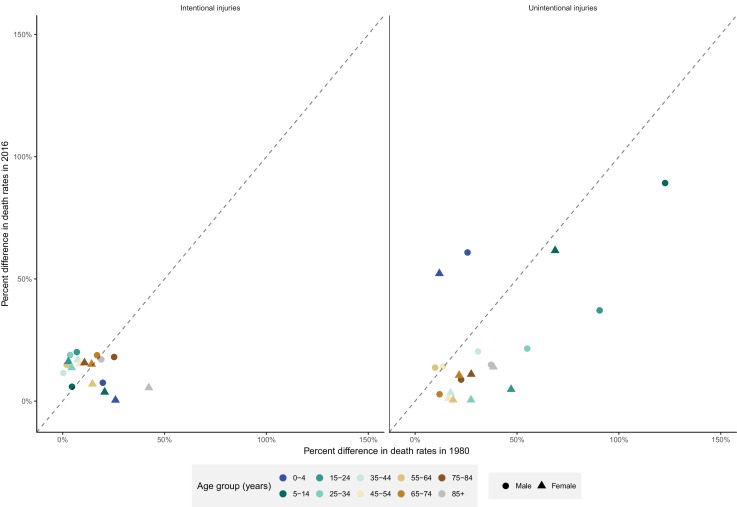
National percent difference in death rates between the maximum and minimum mortality months for specific injuries in 2016 versus 1980, by sex and age group.